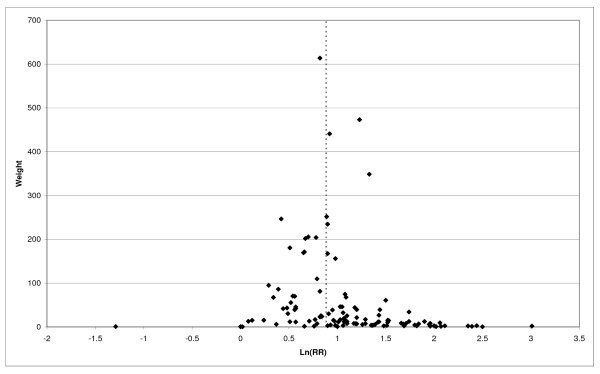
Funnel plot for ever smoking and CB. Funnel plot of the 114 relative risk estimates for ever smoking and CB included in the main meta-analysis in Table 5 against their weight (inverse-variance of log RR). The dotted vertical line indicates the fixed-effect meta-analysis estimate.